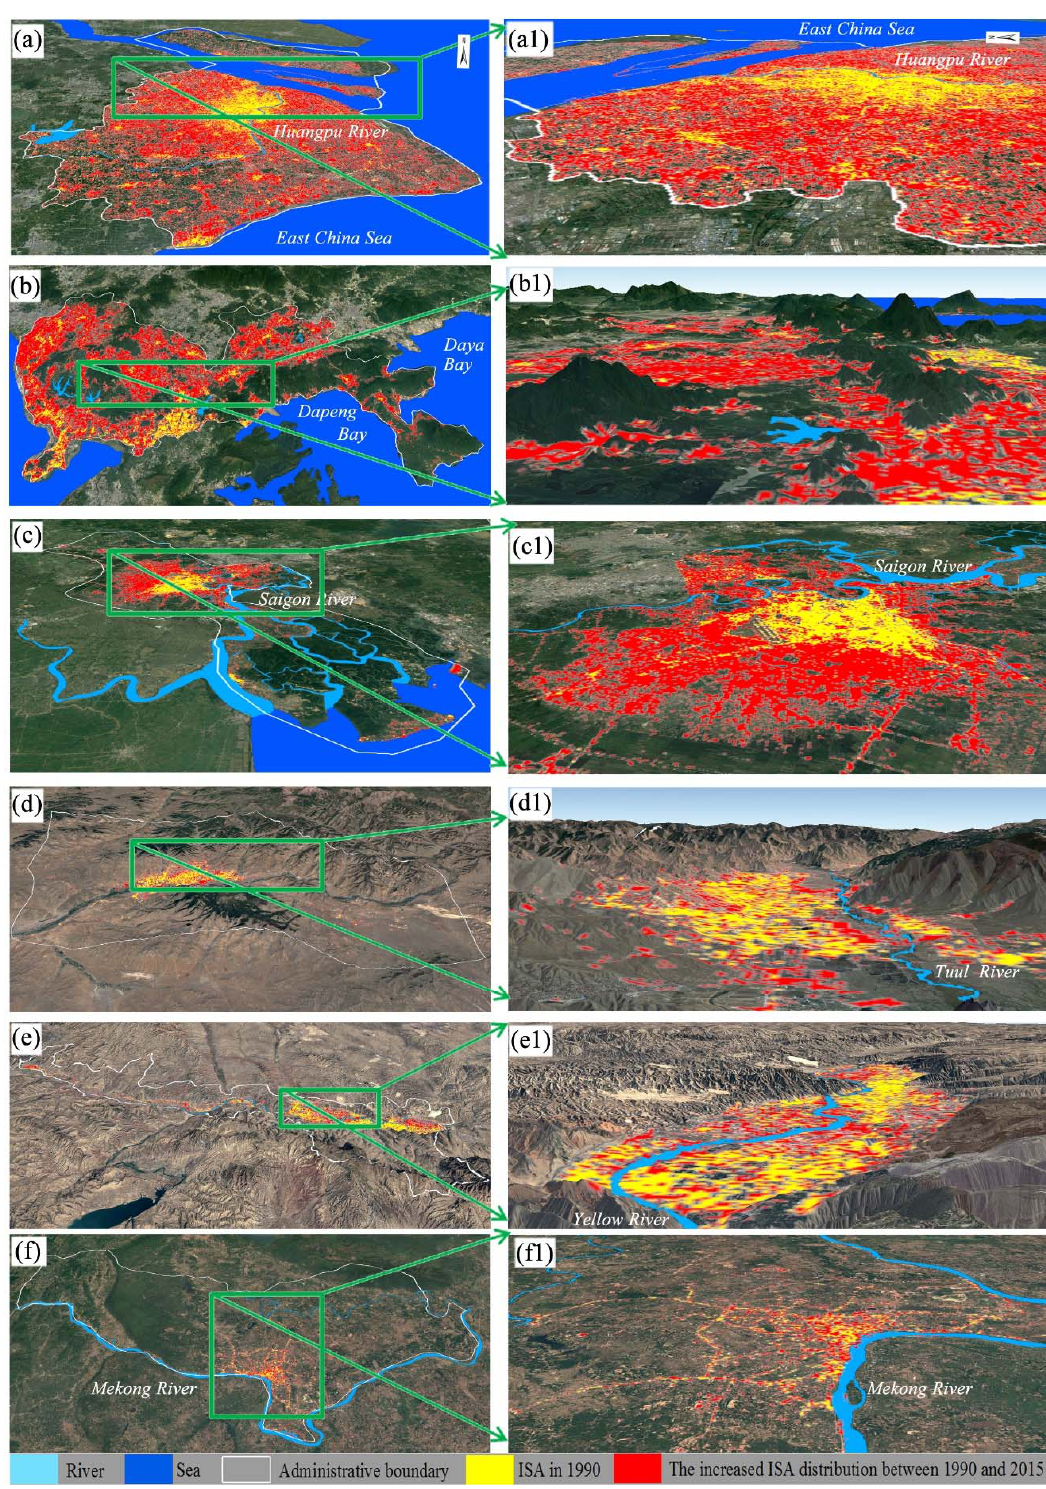
Figure 4. Spatial distribution of impervious surface expansions showing the important roles of topography and rivers on urban expansion patterns and rates; ( a , a1 ) Shanghai, ( b , b1 ) Shenzhen, ( c , c1 ) Ho Chi Minh City, ( d , d1 ) Ulaanbaatar, ( e , e1 ) Lanzhou, and ( f , f1 ) Vientiane.